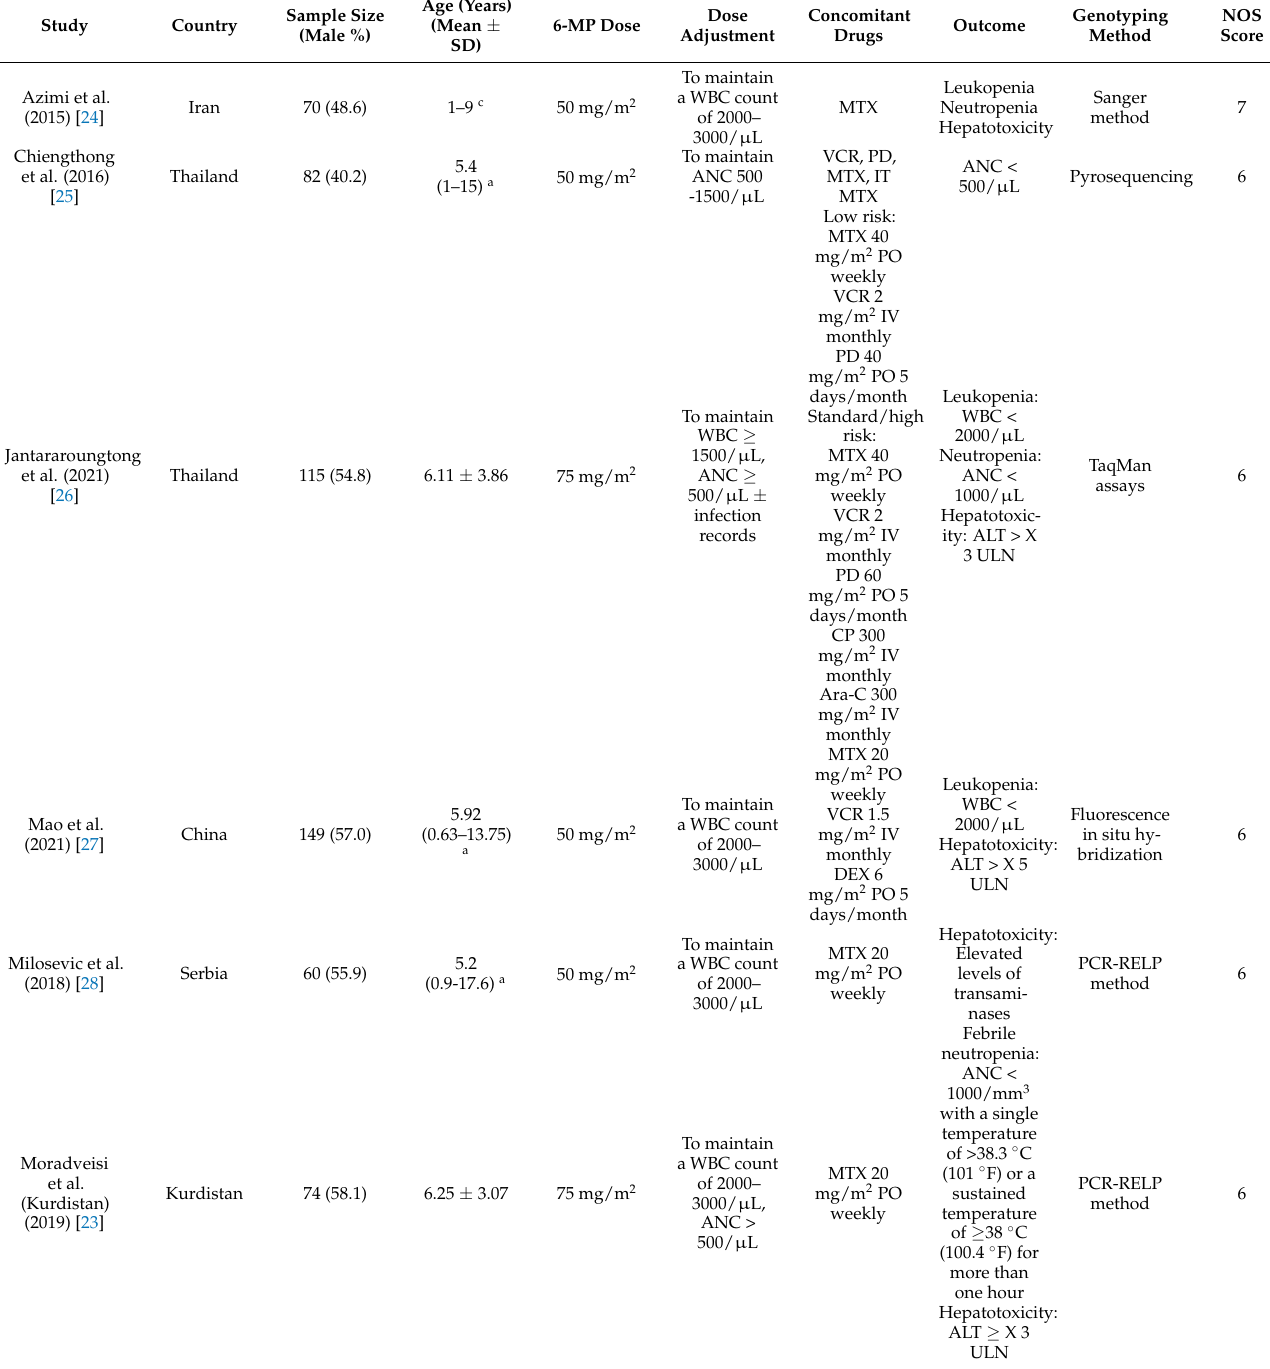
Table 1. Characteristics of studies included in the